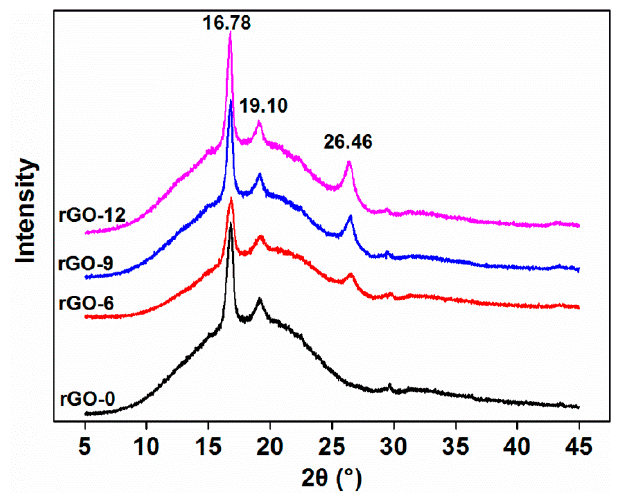
Figure 8. X-ray diffraction (XRD) patterns of the composites with varying rGO content. Figure 8. X-ray di ff raction (XRD) patterns of the composites with varying rGO